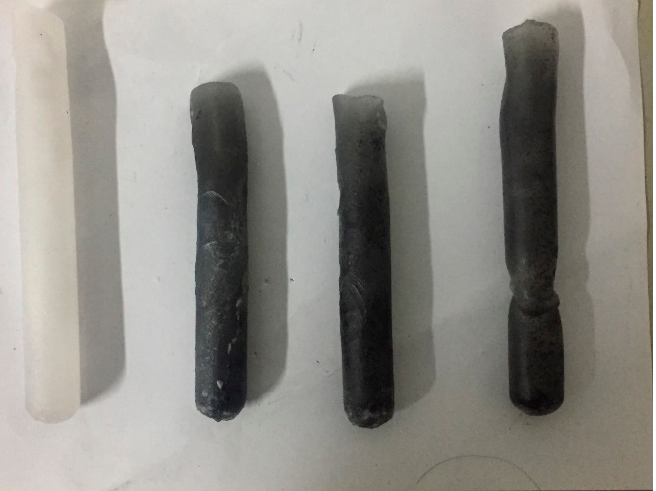
Figure 6. The comparison of dispersion stability of CPCM. Left to right: pure paraffin, 2% EG/paraffin, 2% GO/paraffin, 2% GR/paraffin.